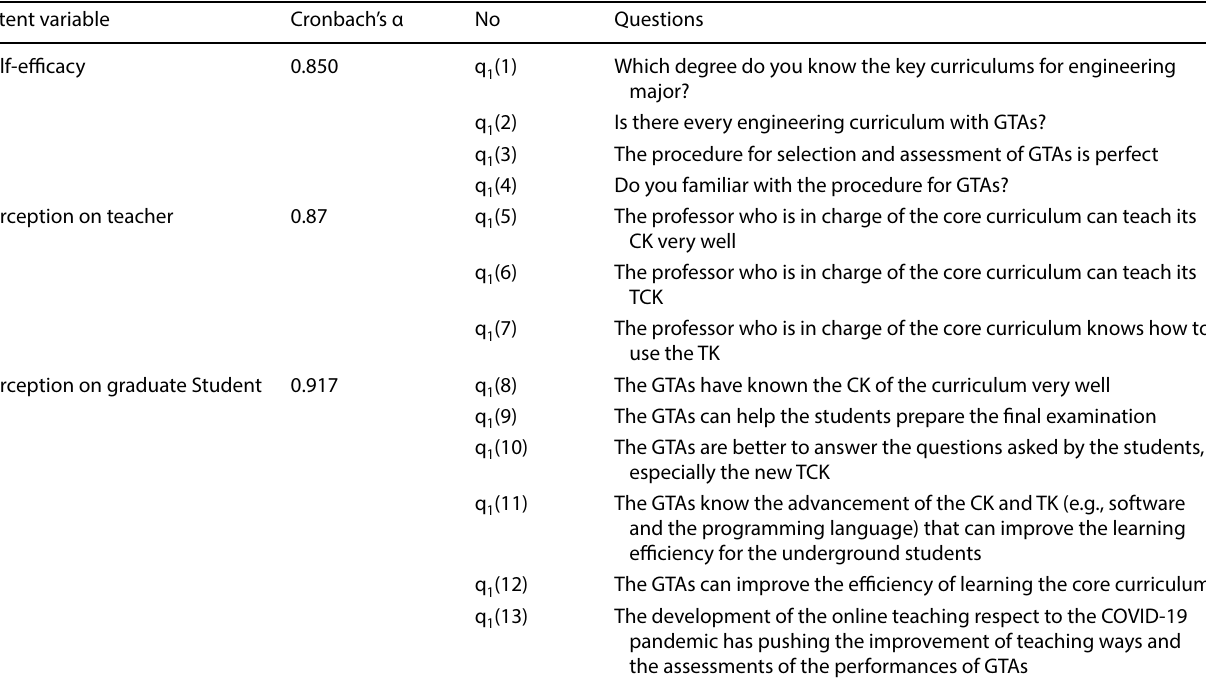
Table 2 Questions for the program